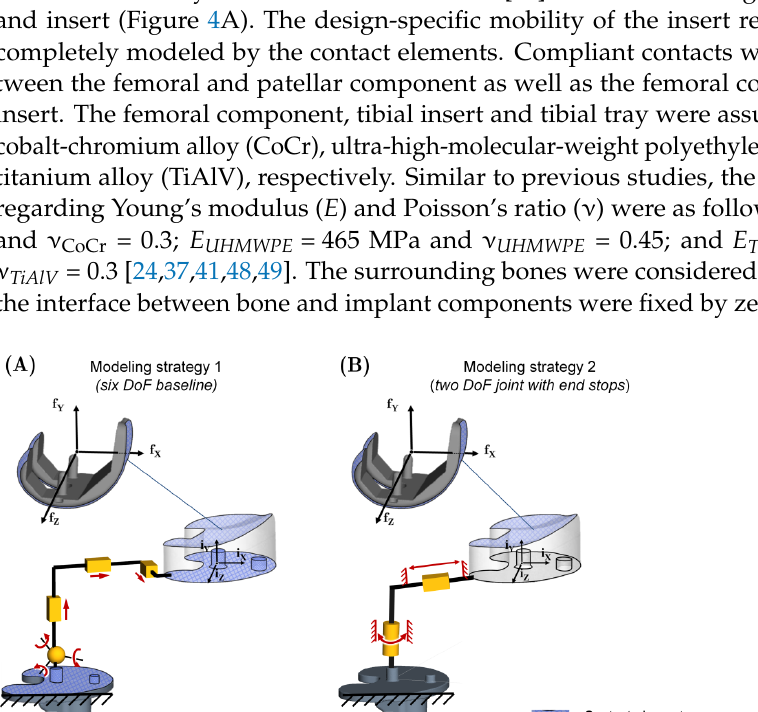
Figure 3. Mobile-bearing (MB) total knee replacement design variants investigated in this study. Baseline MB design variant I ( A ) is the commercially available design (Columbus ® uniaxial rotating platform total knee replacement) with the central pin P C defining the axis of rotation and the ante- riorly positioned pin P A limiting the range of rotation. In MB design variant II ( B ), the anterior pin